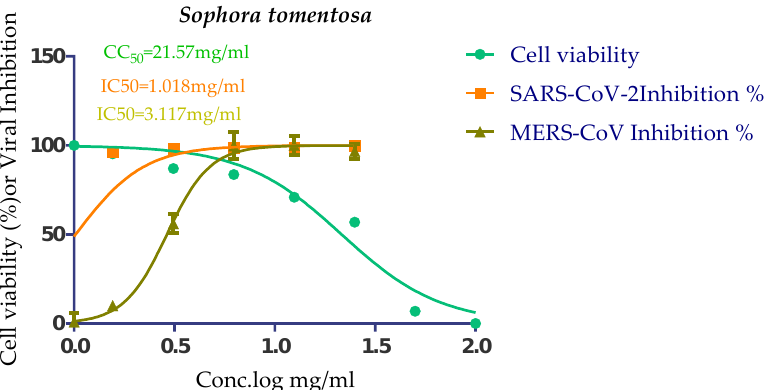
Figure 6. CC 50 and IC 50 antiviral activity of S. tomentosa against SARS-CoV-2 and MERS-CoV. The IC 50 of each test was calculated using nonlinear regression analysis in triplicate for each concentration used. The best-fitting line was drawn between log concentrations and viral inhibition % using GraphPad Prism software.